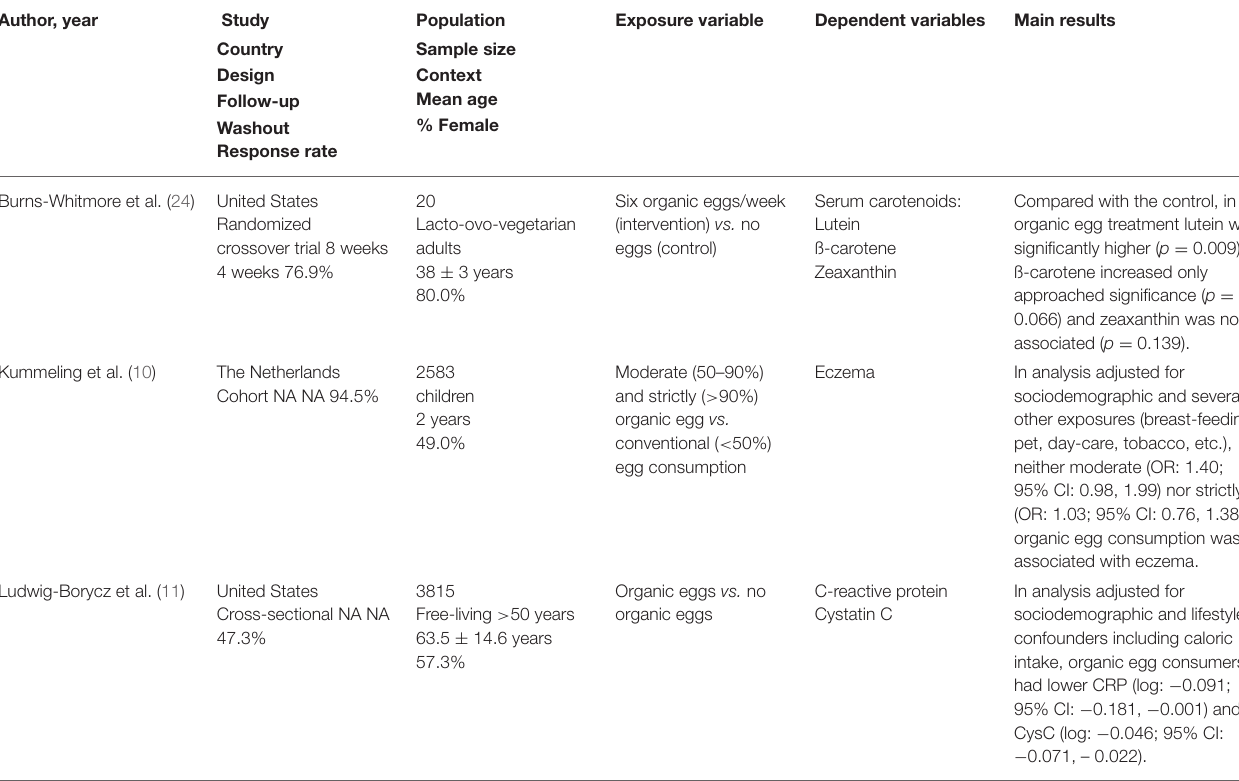
TABLE 1 | Characteristics of the included